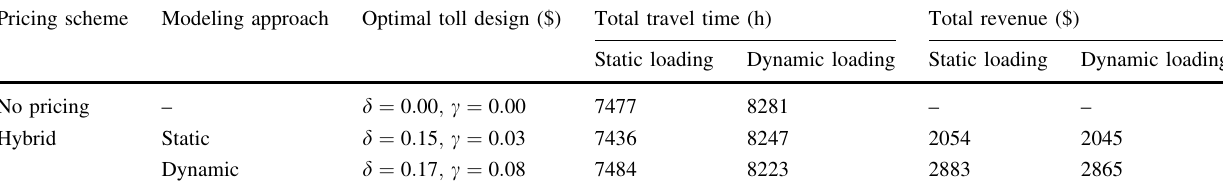
Table 9 Optimal hybrid toll designs from static and dynamic modeling approaches for Sioux Falls Pricing